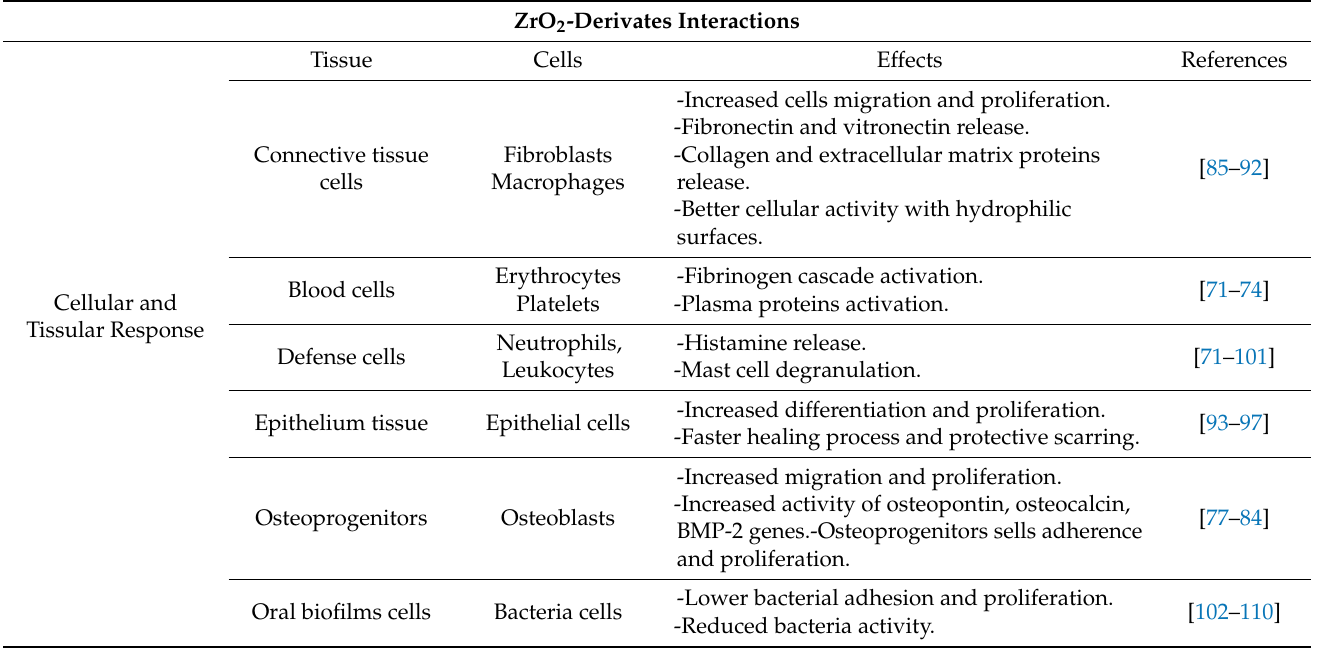
Table 2. Summary of the current cellular and tissular interactions of the ZrO 2 derivates. ZrO 2 -Derivates